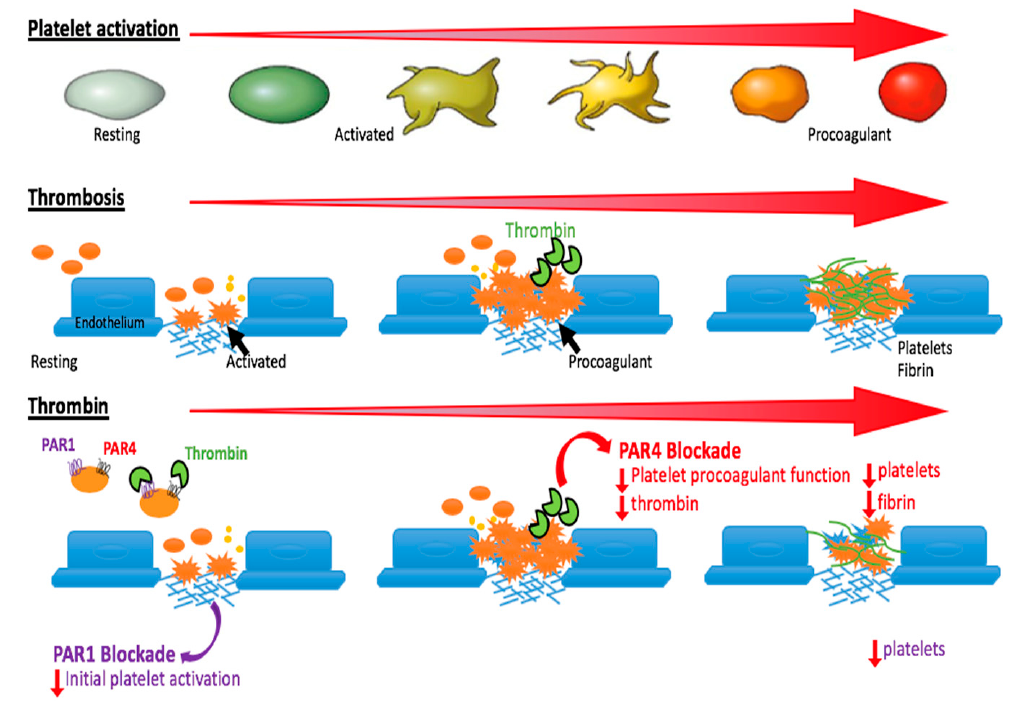
Figure 2. Top: Increasing platelet activation, moving from resting platelets (unactivated; gray) through to initial shape change (yellow) and ultimately PS-exposing procoagulant platelets (red). Middle: Increasing extent of thrombosis correlates with increasing platelet activation. When a blood vessel gets injured, platelets adhere to the site of injury through the binding of exposed subendothelial proteins in the vasculature and glycoprotein receptors on the platelet. Adhesion triggers initial platelet activation, shape change and release of molecular contents. Following activation, phosphatidylserine is exposed on the platelet surface, and these platelets become procoagulant, resulting in further thrombin generation and platelet activation. Bottom: Effects of blocking PAR1 (early stage platelet activation; purple) versus PAR4 (late stage platelet activation; red). Initial platelet function is driven by low thrombin concentrations and PAR1 activation. Later platelet responses, including procoagulant platelet function, is driven by PAR4. Reproduced with permission from Reference [31].